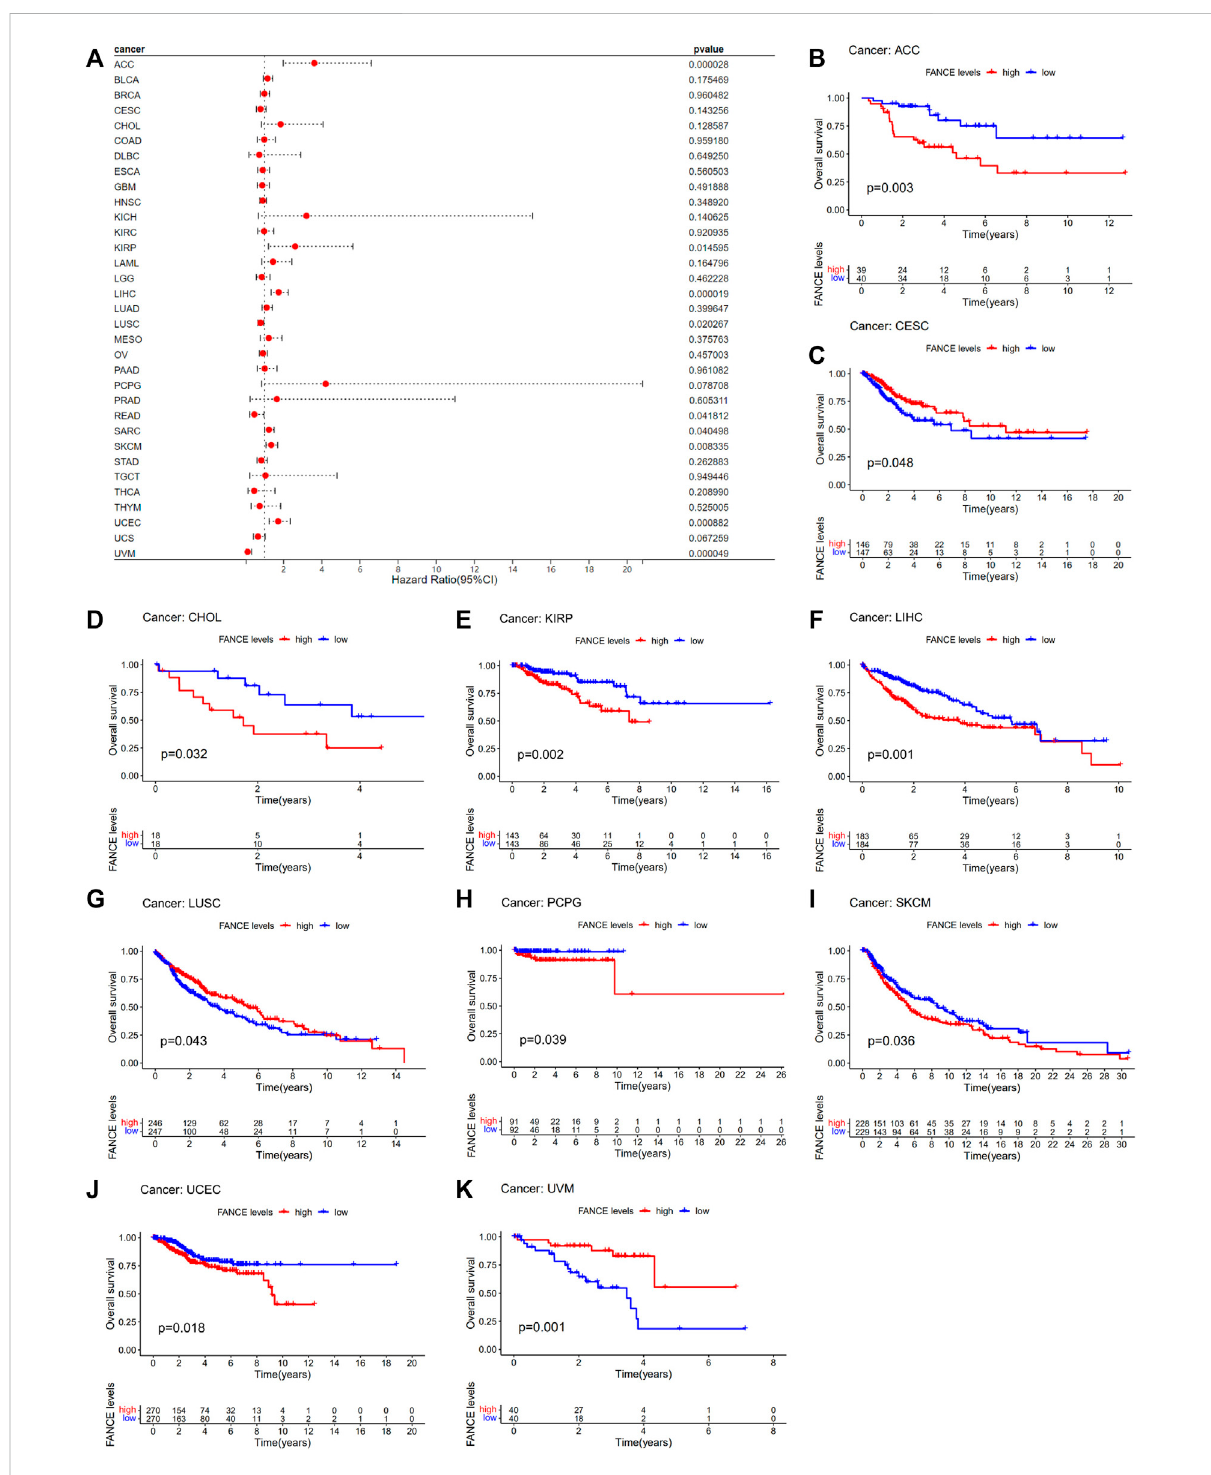
FIGURE 4 Correlation between FANCE expression and overall survival (OS) using data from the TGCA database. (A) Forest plot of FANCE expression and OS in 33 cancers. (B – K) The Kaplan – Meier survival analysis for FANCE expression and OS in 10 cancers. * p < .05; ** p < .01; and *** p <